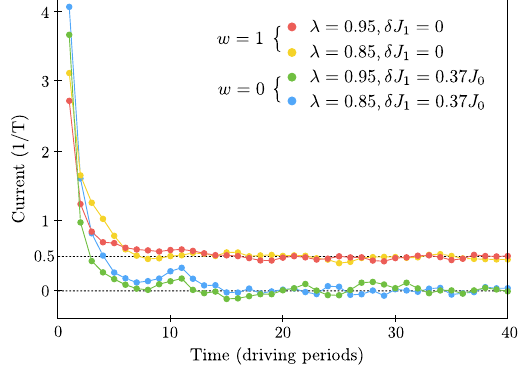
FIG. 4. Universality of the quasi-steady state. Time traces of the current are shown for four choices of parameter values for the single-particle part of the Hamiltonian, Eq. (1), showcasing the topologically trivial ( w ¼ 0 ) and nontrivial ( w ¼ 1 ) regimes. After a transient of several driving periods, the current saturates to the value J ≈ w ρ =T , where ρ ¼ 0 . 5 is the density of particles, per unit cell. In all cases, the system is initialized by filling all states with crystal momentum values in the range 0 ≤ k < π =a , in a single Floquet band. The simulation was done with ω ¼ 0 . 23 J 0 and U ¼ 2 J 0